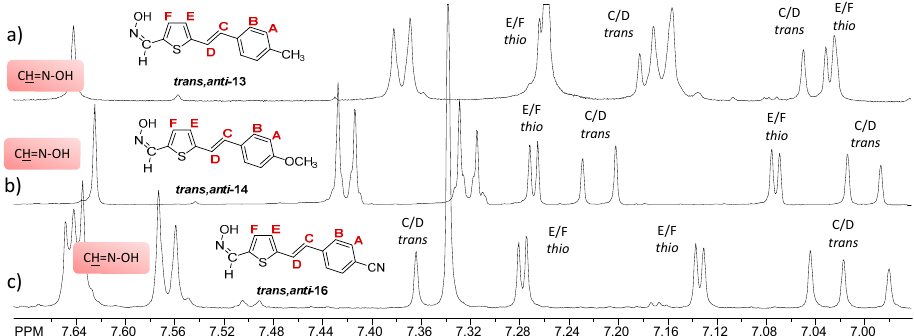
Figure 3. Downfield region of the 1 H NMR spectra (CDCl 3 +CD 3 OD) of the oximes trans,anti - 13 ( a ), trans,anti - 14 ( b ), and trans,anti - 16 ( c ).